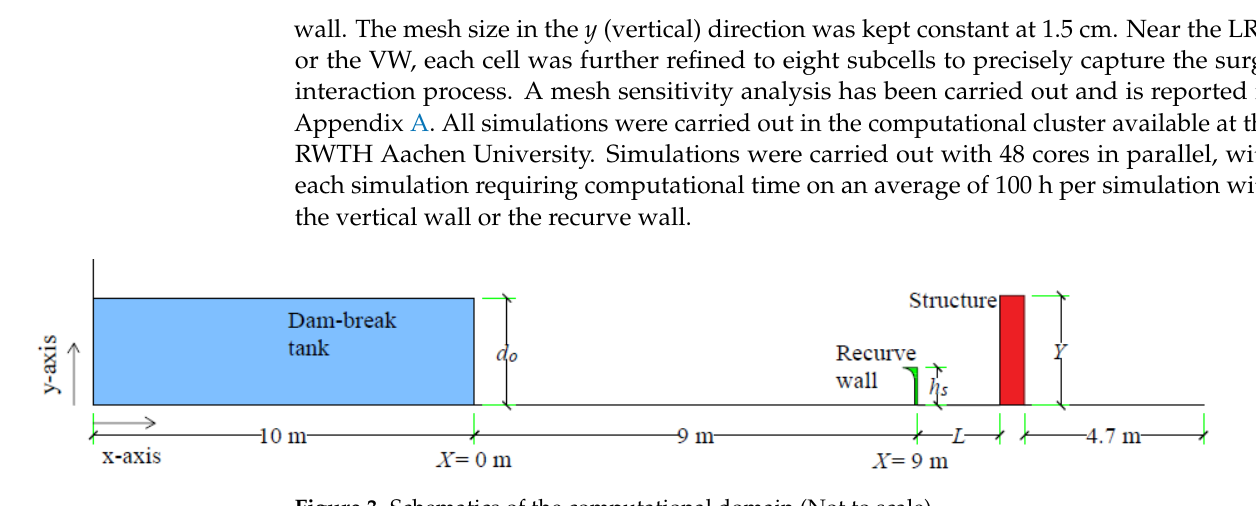
Figure 3. Schematics of the computational domain (Not to scale).